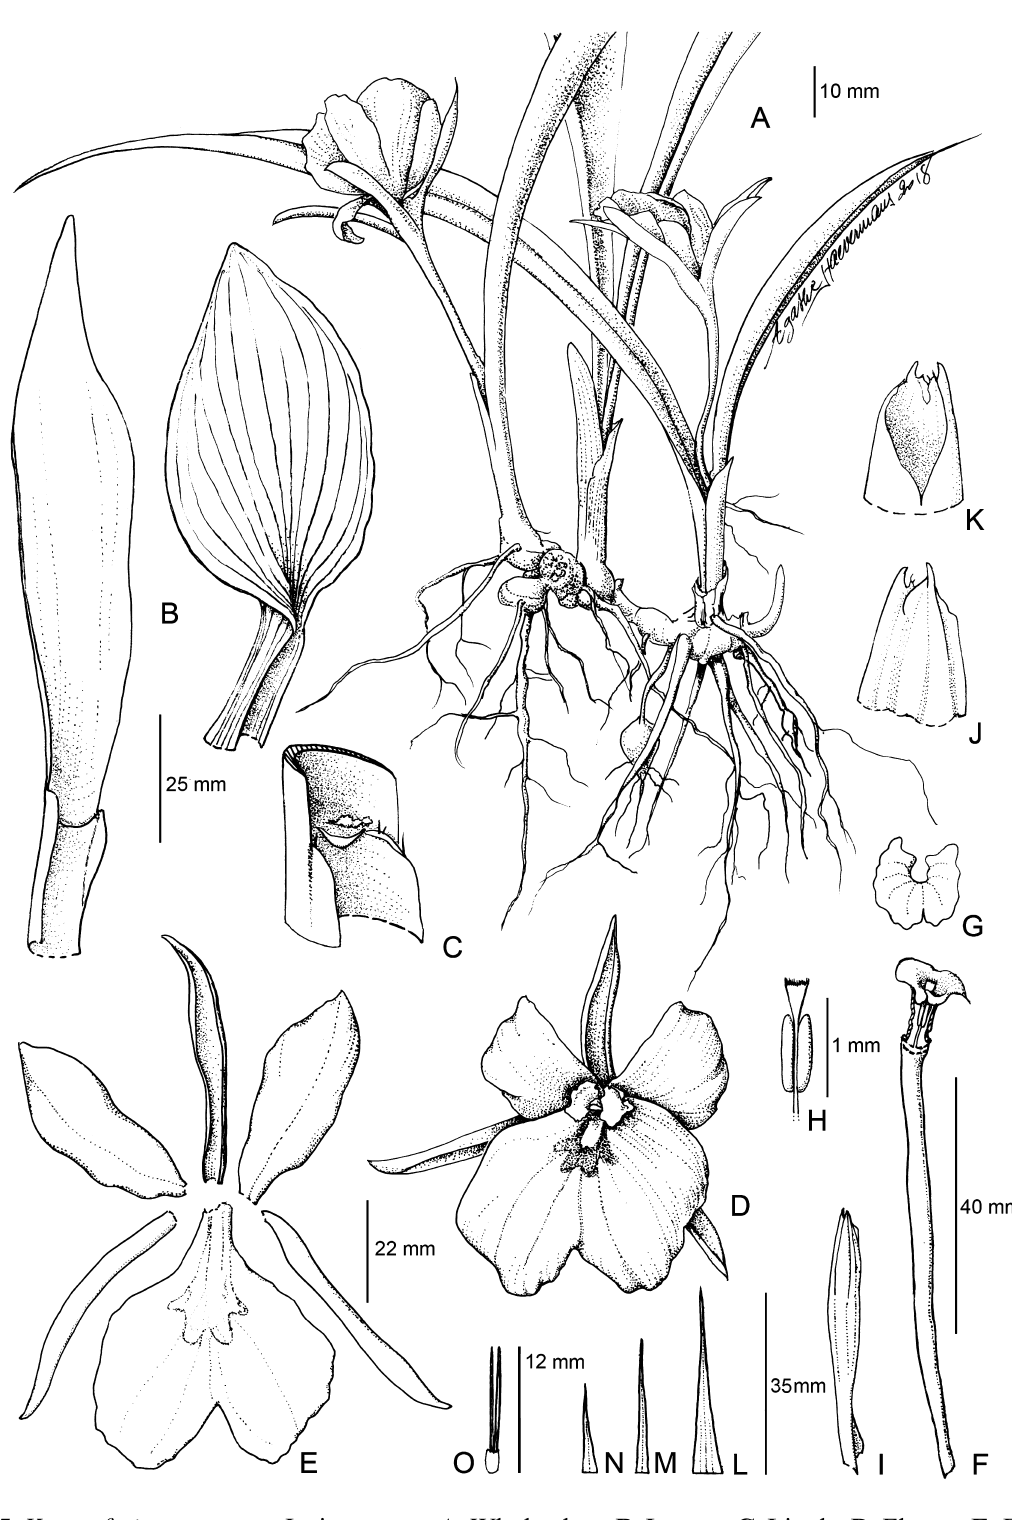
Fig. 5. Kaempferia pascuorum Insis. sp. nov. A . Whole plant. B . Leaves. C . Ligule. D . Flower. E . Flower dissected. F . Floral tube with anther attached. G . Anther crest from above. H . Stamen and stigma. I . Calyx. J–K . Apex of calyx from two different views. L . Bract. M–N . Bracteoles. O . Ovary and epigynous glands. Drawing from the type material by Agathe Haevermans ( O. Insisiengmay et al. OI. 116